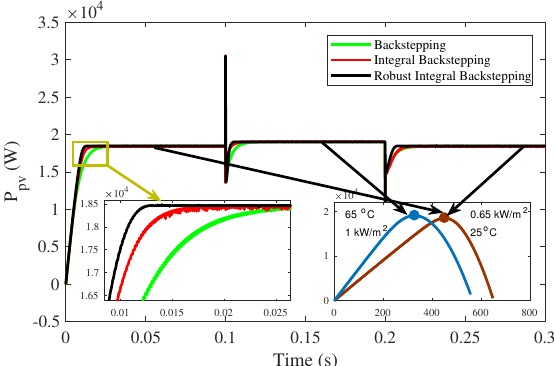
Figure 9. Output power of PV array under varying irradiance and varying temperature.